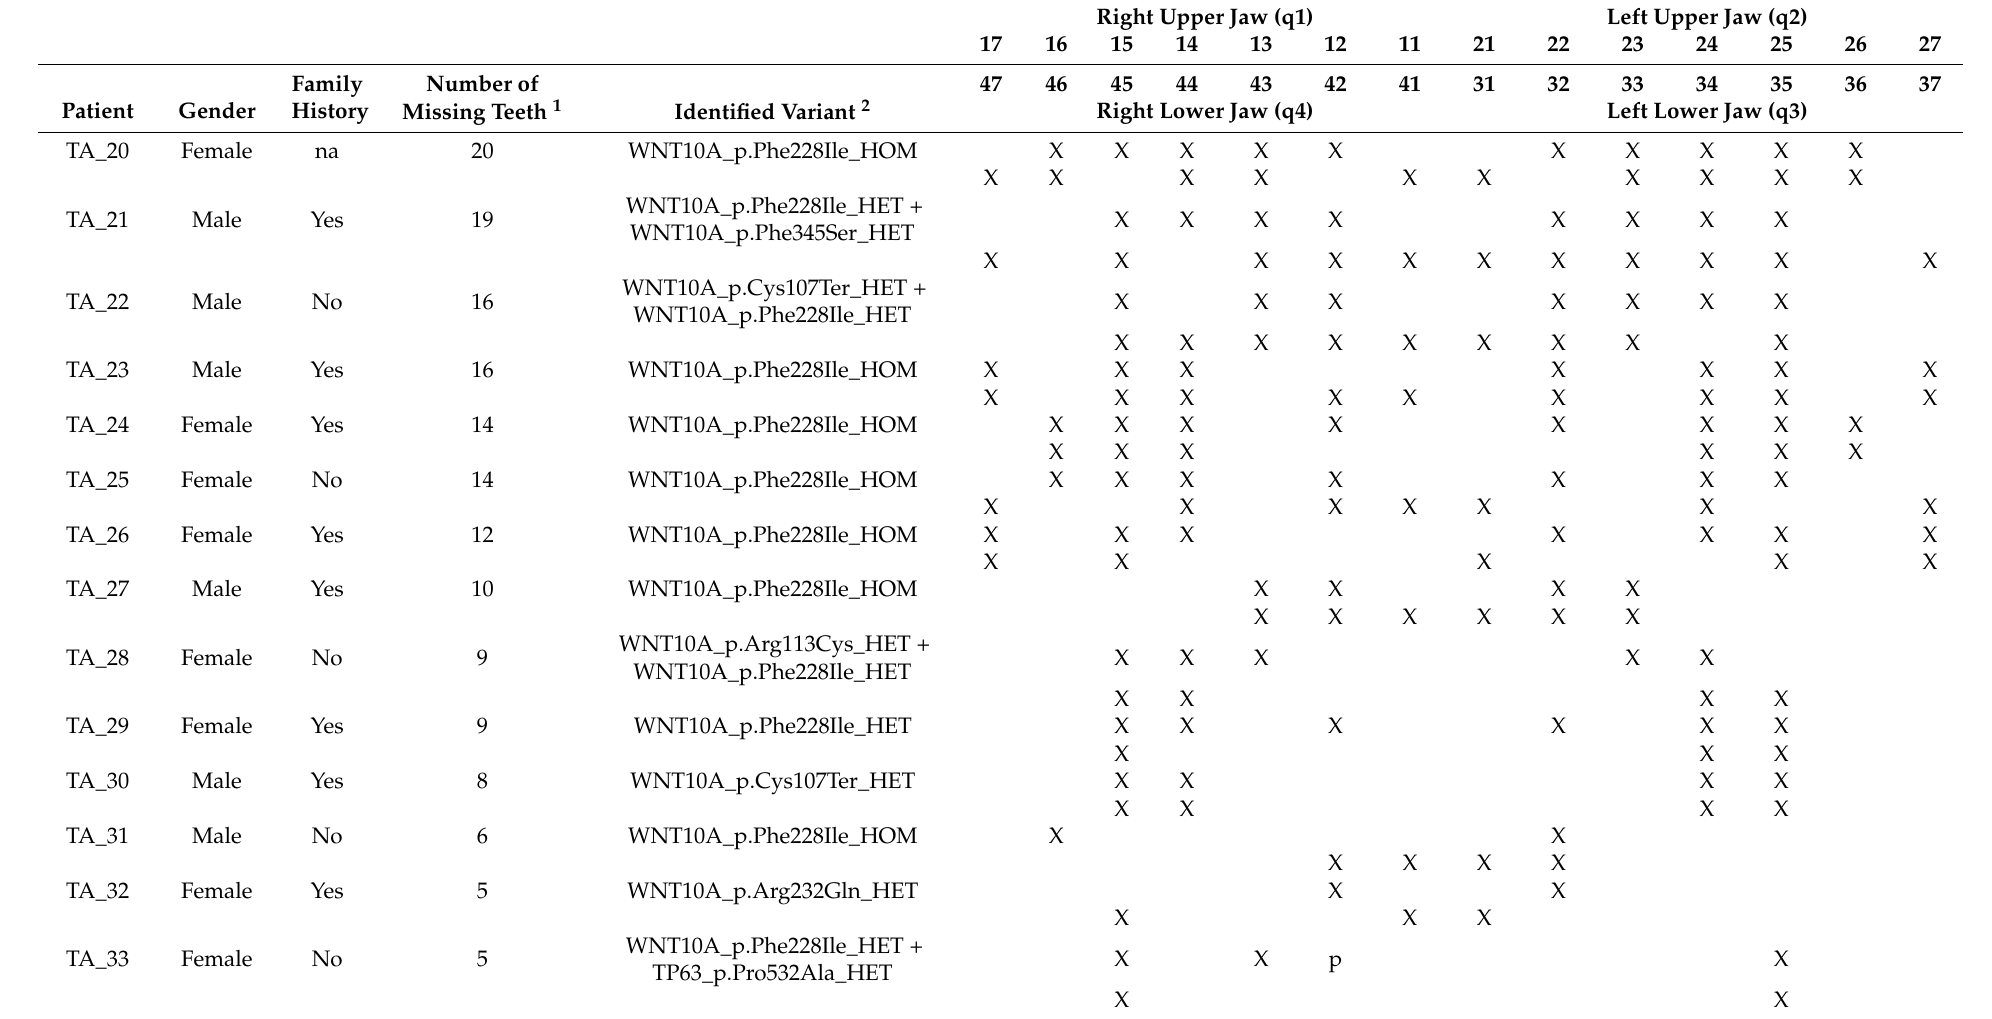
Table 4. Dental phenotype of patients with WNT10A gene